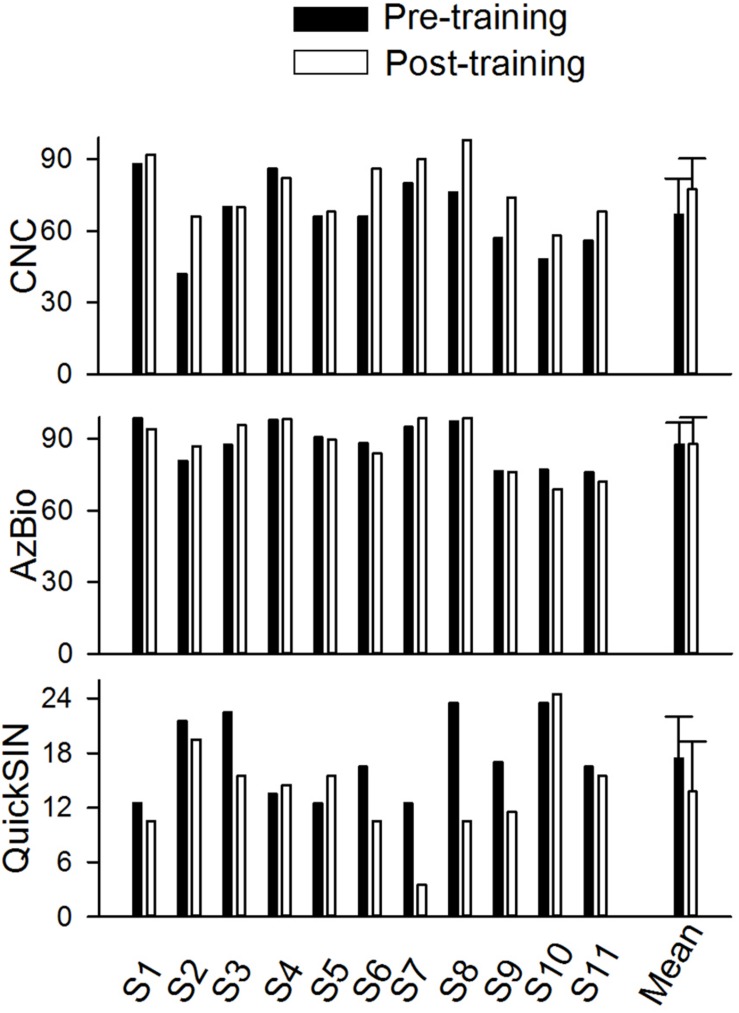
The pre- and post-training speech perception scores for CNC word (percent correct), AzBio sentence in quiet (percent correct), and QuickSIN (dB) in individual subjects and the mean values of all individuals (n = 11). The error bar indicates 1 standard deviation.